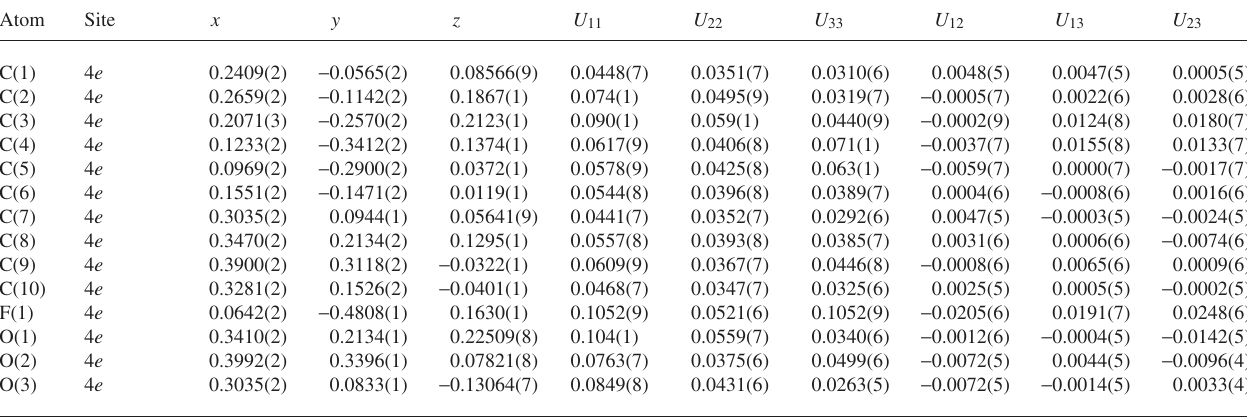
Table 3. Atomic coordinates and displacement parameters (in Å 2 ) .